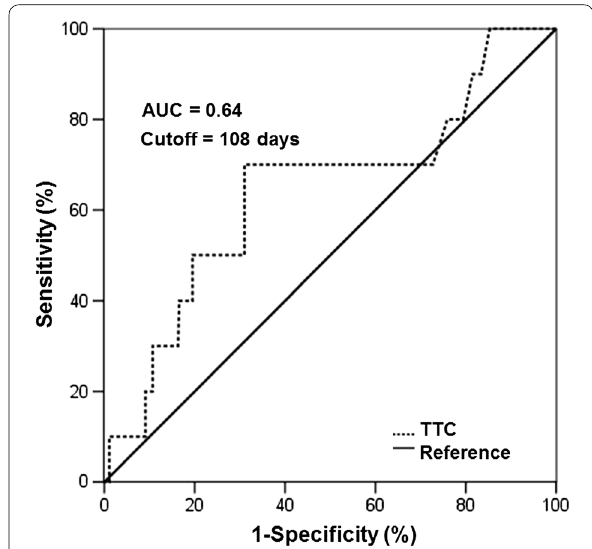
Fig. 1 Receiver operating characteristic (ROC) curve analysis detected the cutoff point of time to complete remission (TTC) as 108 days. AUC area under